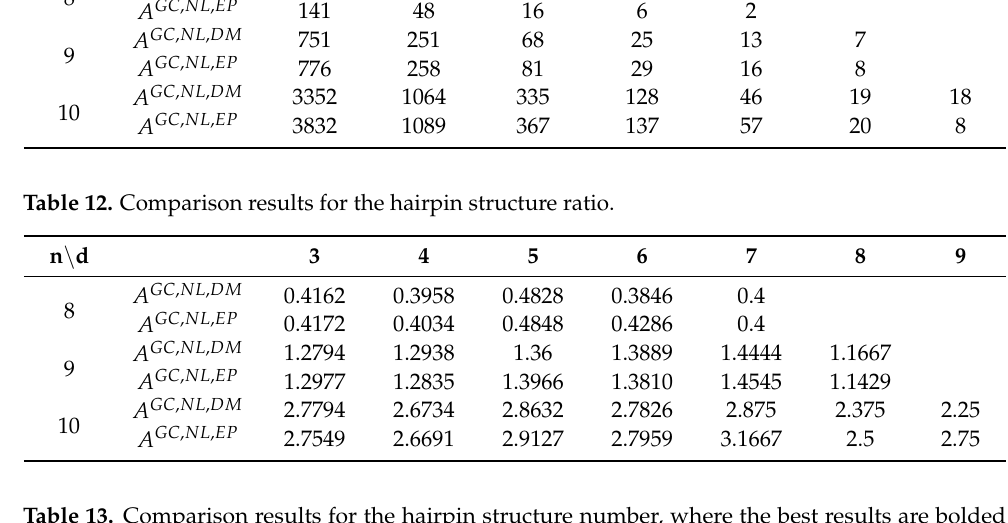
Table 13. Comparison results for the hairpin structure number, where the best results are bolded to indicate.